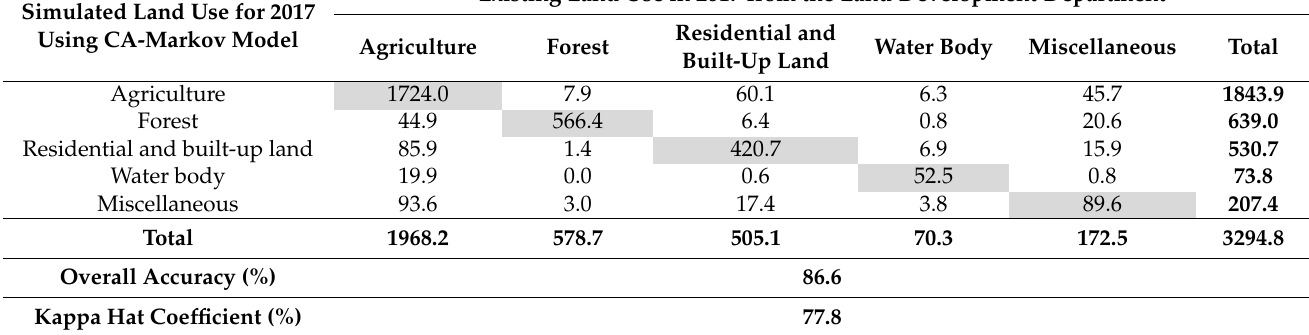
Table 2. Comparison of land use in 2017 obtained from the Land Development Department and CA-Markov